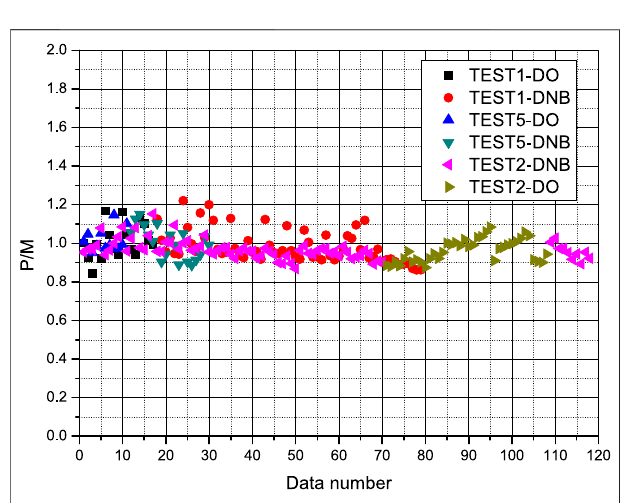
FIGURE 8 | Distribution of P/M in TEST 1, TEST 2, and TEST